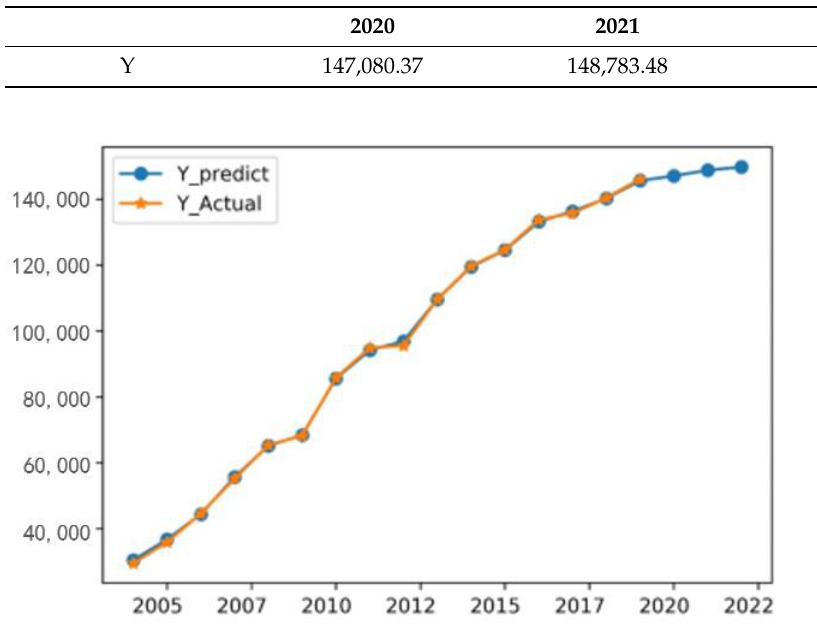
Figure 10. The GD’s MIDF for the next three years.